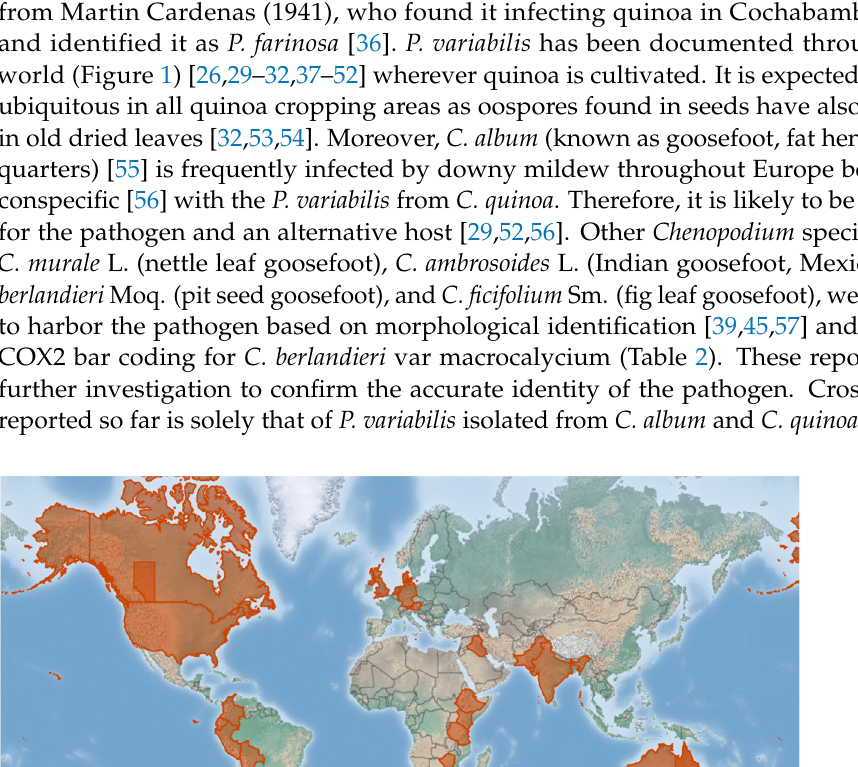
Peronospora variabilis hyphotetical disease cycle